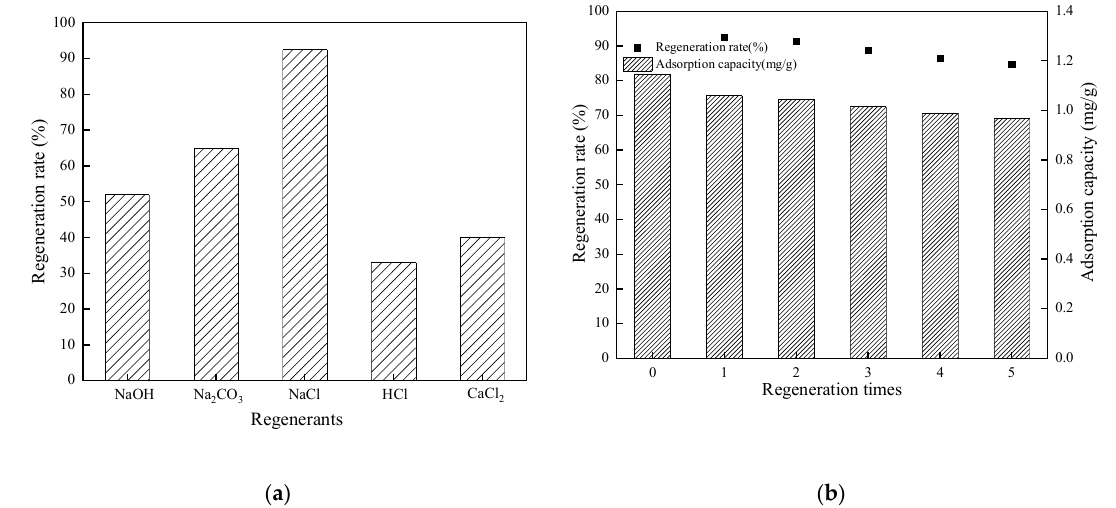
Figure 8. Regeneration results of CTS-ZMS ( a ) regenerants and ( b ) regeneration times.